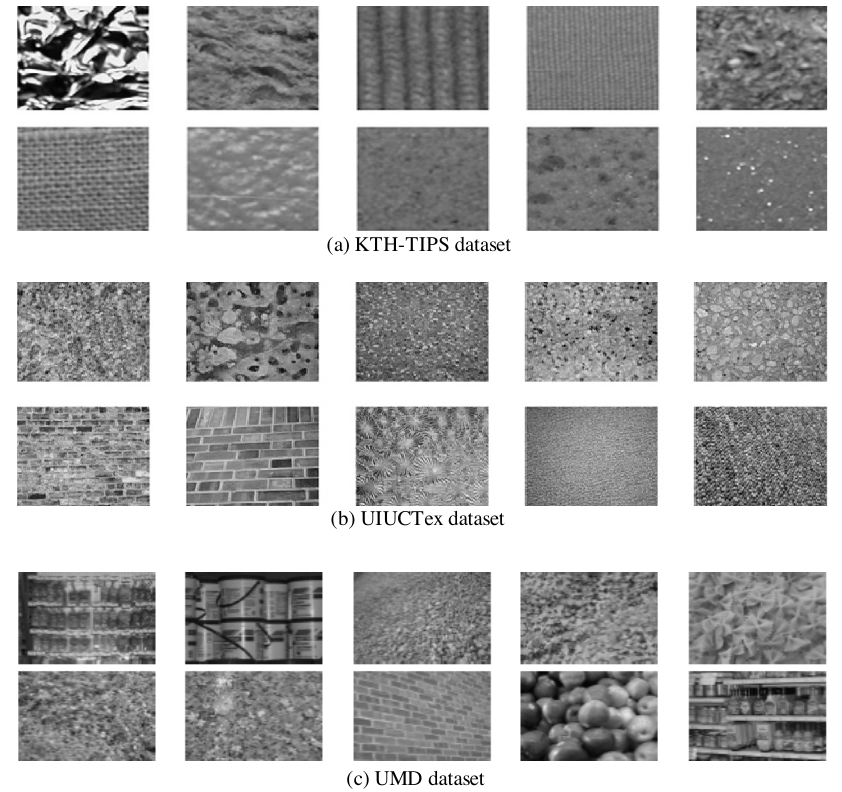
Figure 3. Samples of textures from different datasets ( a ) KTH-TIPS, ( b ) UIUCTex, and ( c ) UMD